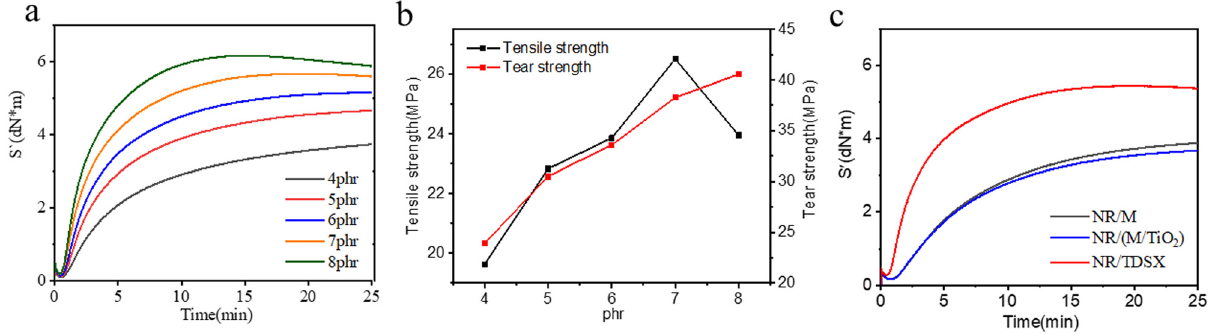
Figure 3: ( a ) The curing curve of natural rubber composites with di ff erent contents of TDSX; ( b ) the tensile strength and the tear strength of natural rubber composites with di ff erent contents of TDSX; and ( c ) the curing curve of NR/M, NR/ ( M/TiO 2 ) , and NR/TDSX.